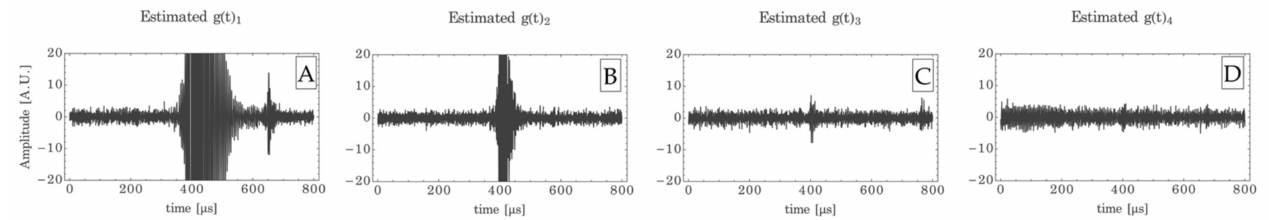
Figure 10. Non-contact point focused ultrasonic probes experiment: g i ( t ) functions for the four orders con- sidered (expanded representation scale) in the case of the higher SNR value (31 [dB]). Plots ( A – D ): functions